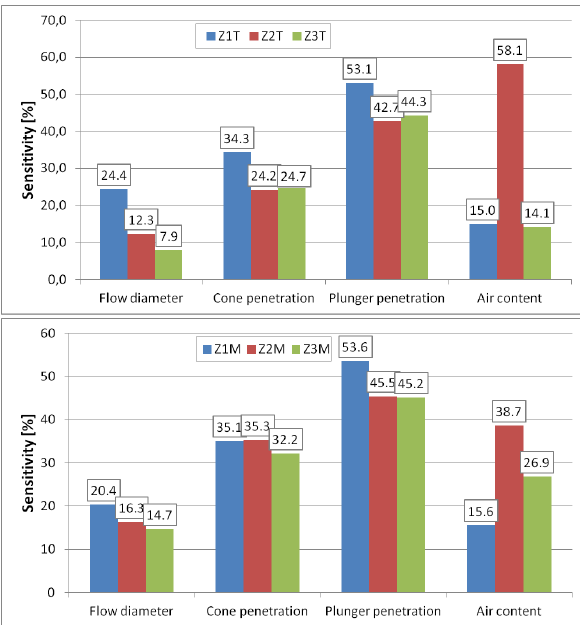
Figure 3: The sensitivity of the properties of plasters (top) and mor- tars (bottom) to ± 10% mistake of water